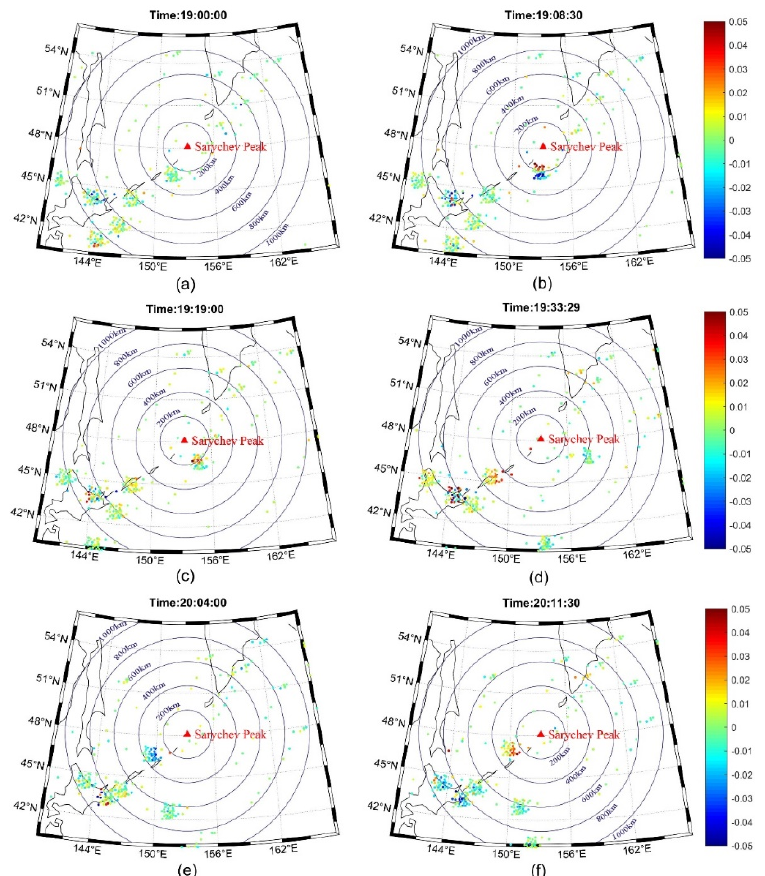
Figure 4. The traveltime diagram plotted by using satellites G20 and G23 within the time span 18:30 − 20:30 UT on 14 June 2009 shows the most prominent CVIDs. The vertical red solid line indicates the explosion time. Color represents the appropriate TEC amplitude.